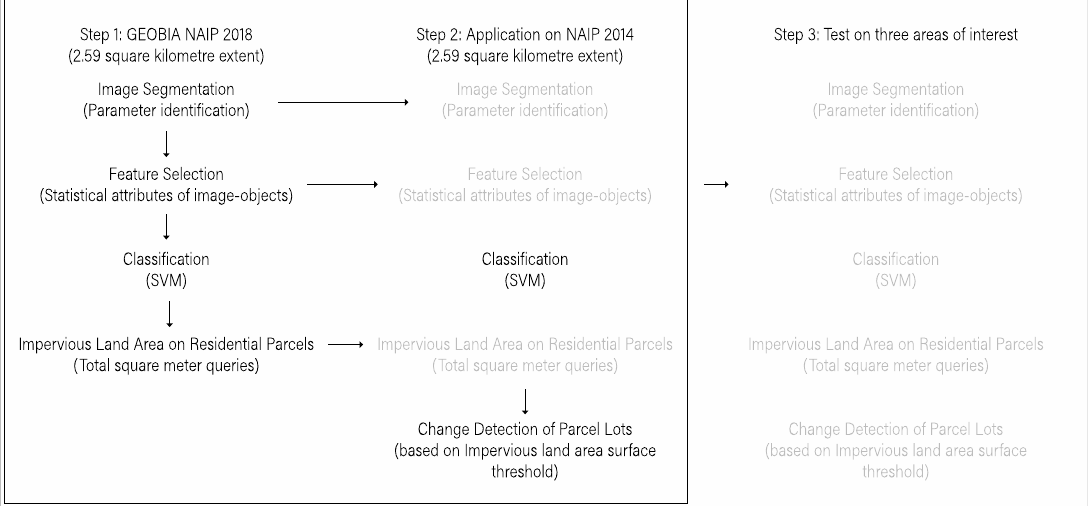
Figure 3. OBIA workflow diagram.